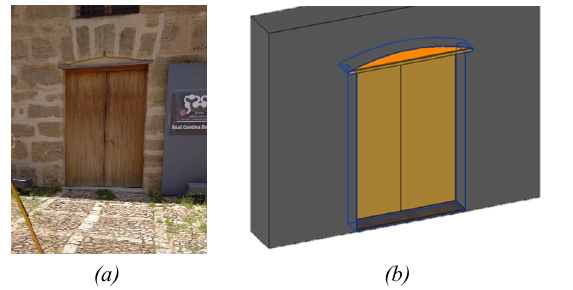
Figure 12. The modeling of the main entrance door: the real